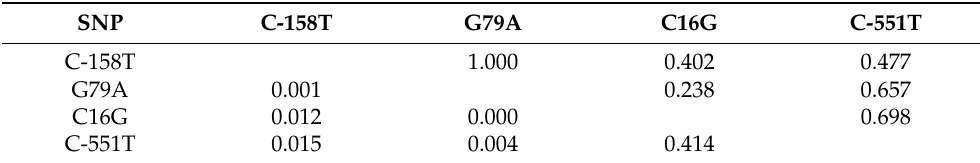
Table 6. Linkage disequilibrium analysis of the β -like globin SNPs.